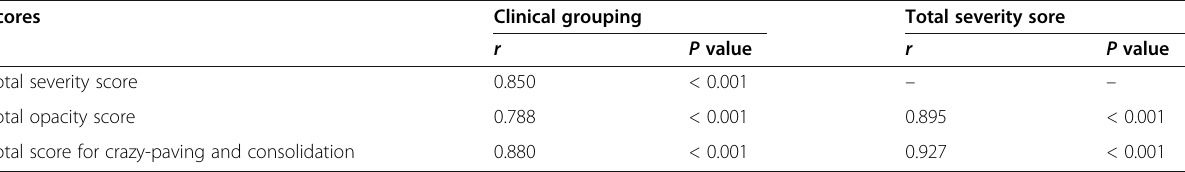
Table 4 Spearman ’ s correlation between total severity score, total opacity score, and total score for crazy-paving and consolidation in relation to clinical grouping